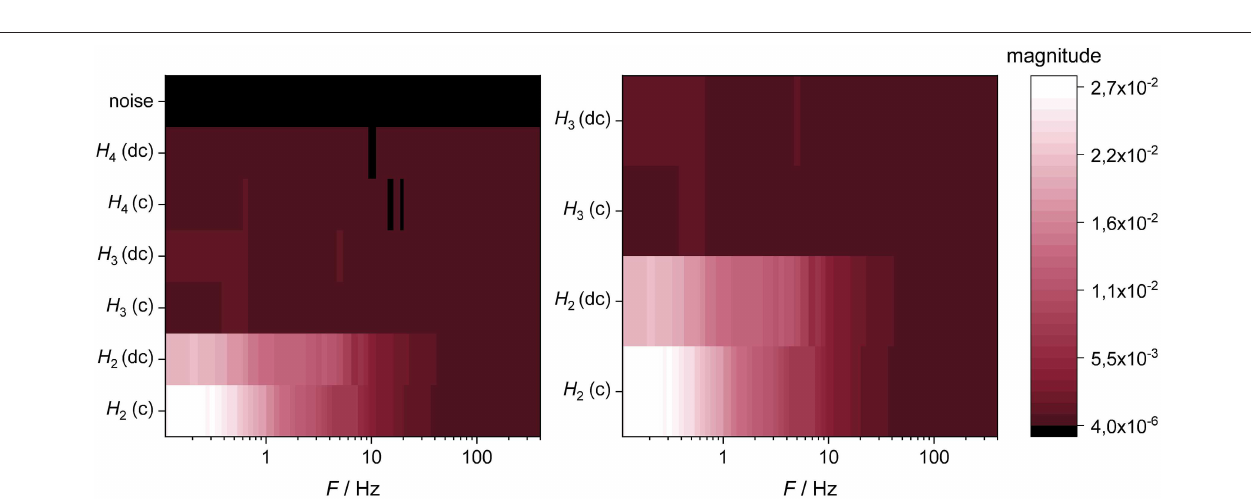
ion-battery at 3.7 V and 0 ◦ C are further shown. The